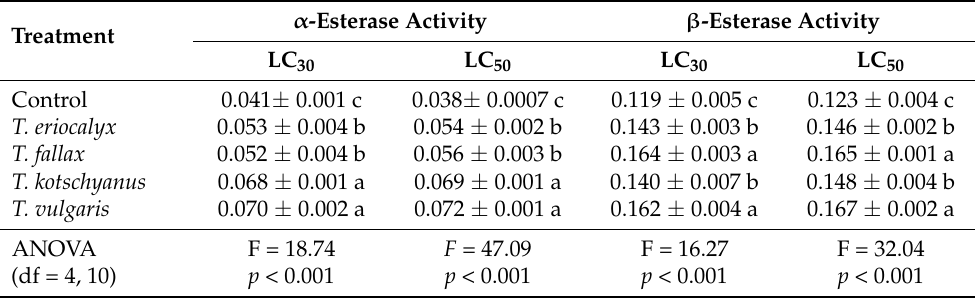
Table 4. The effects of LC 30 and LC 50 values of Thymus eriocalyx , T. fallax , T. kotschyanus , and T. vulgaris essential oils on esterase enzymes activity ( µ mol/min/mg protein) (mean ± SE) of Rhyzopertha dominica adults.